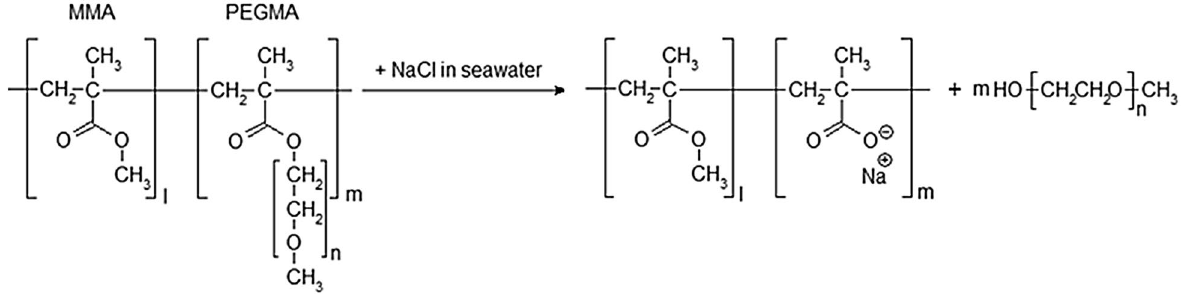
Figure 1. Hydrolysis reaction of